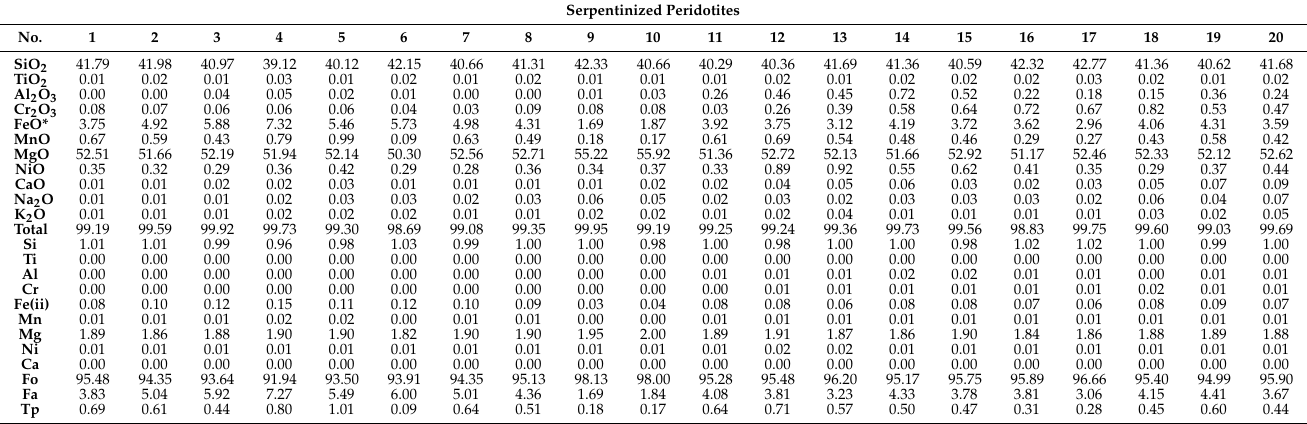
Table 1. Representative microprobe analysis of